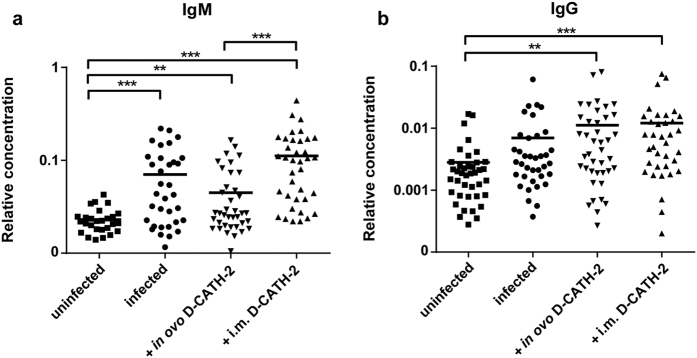
E. coli specific antibody levels in serum at 7 days post challenge. Antibodies were measured using an ELISA. (a) IgM, (b) IgG. Relative concentrations were calculated based on a standard curve of pooled serum samples. Data were analyzed by one-way ANOVA using a Games-Howell post-hoc test for non-equal variances for IgM results and a Tukey post-hoc test for IgG results. **p < 0.01, ***p < 0.001.